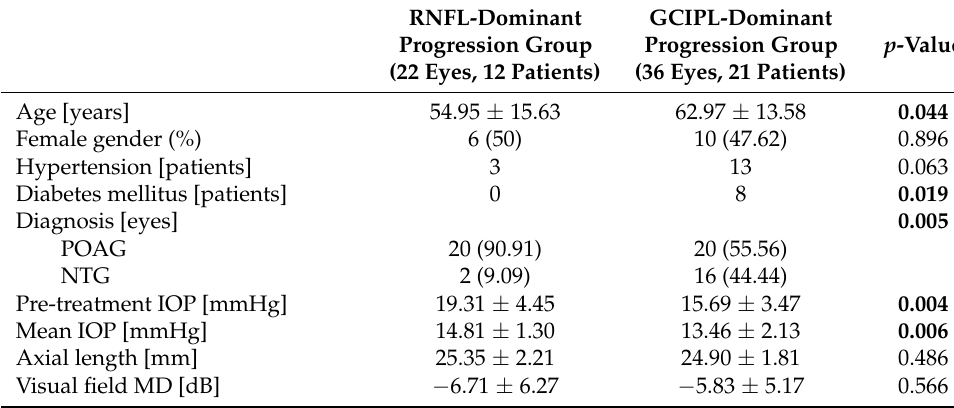
Table 1. Baseline